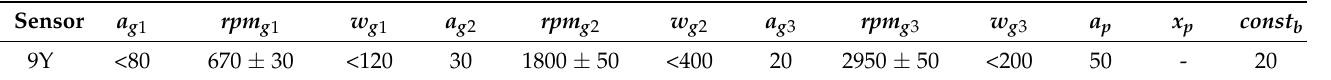
Table 9. Healthy state operation decomposed function parameters by the DE